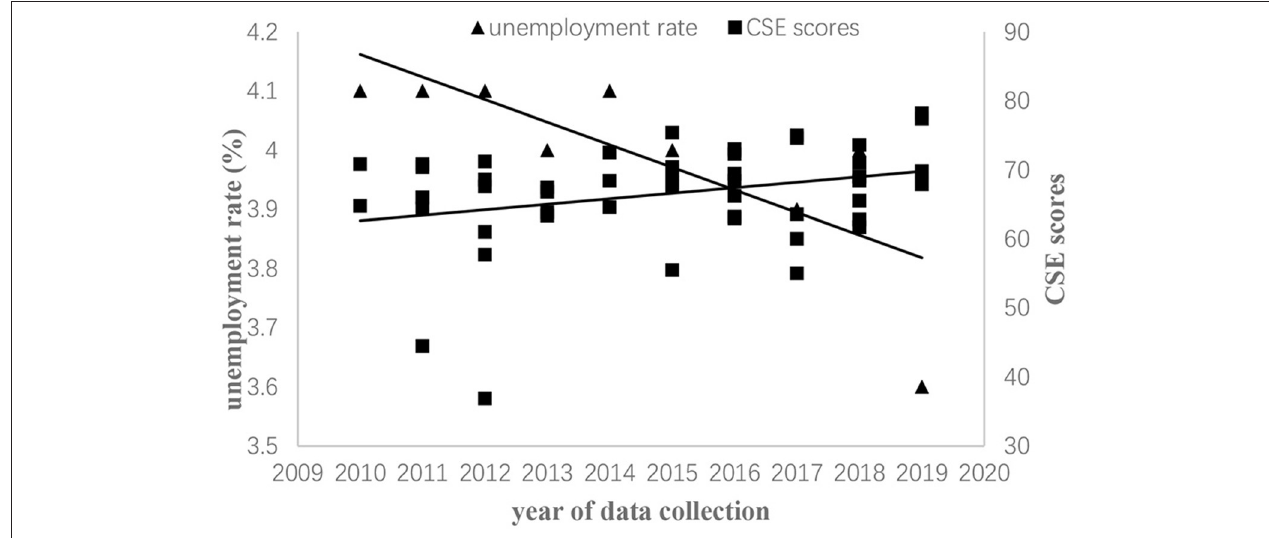
FIGURE 3 | Scatter plot of the unemployment rate and CSE scores among Chinese employees, 2010–2019.